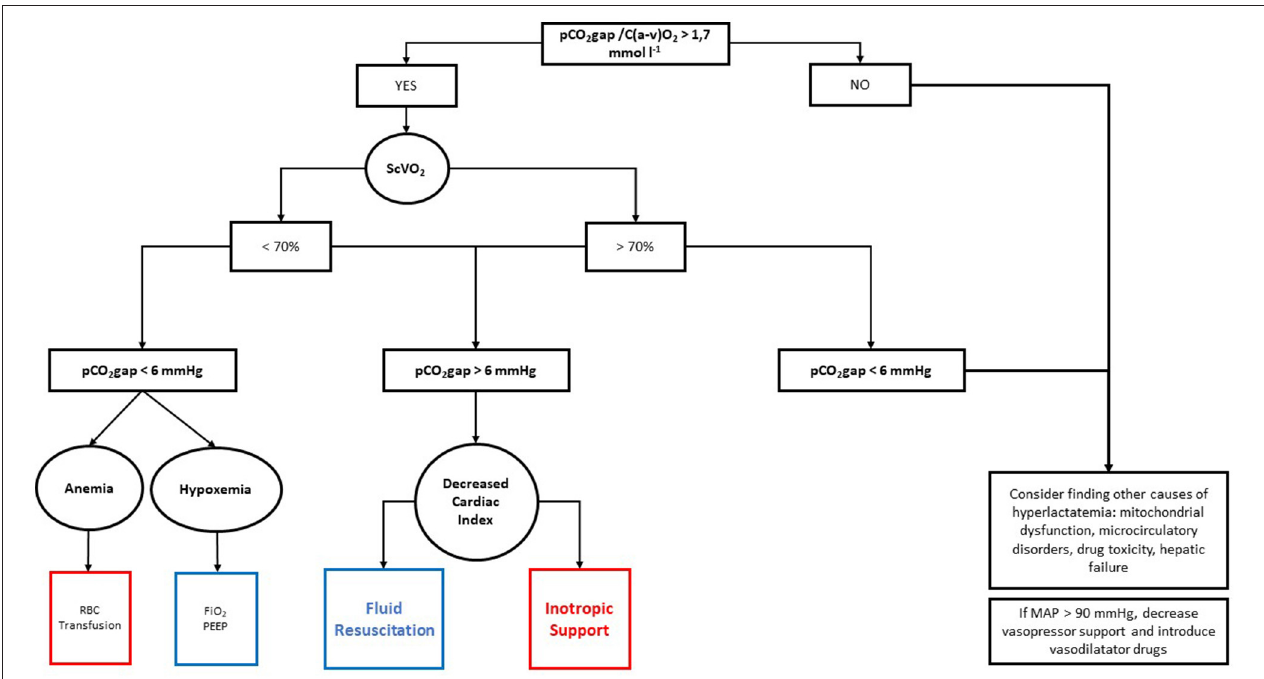
FIGURE 1 | Hemodynamic algorithm based on pCO 2 gap/P(a–v)O 2 ratio. RBC, red blood cell; SvO 2 , mixed venous oxygen saturation; PEEP, positive end-expiratory pressure; FiO 2 , fraction of inspired